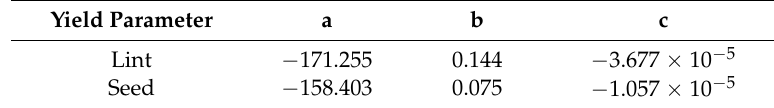
Figure 4. Yield response to soil matric potential. Table 9. Coefficients of the quadratic equation: soil matric potential = a + b × yield + c × yield 2 . Yield